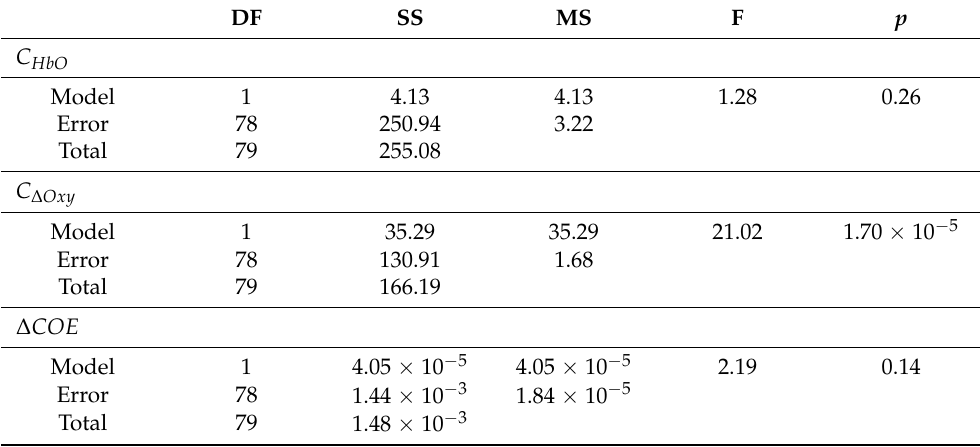
Table 3. ANOVA on gender and three cerebral oxygen